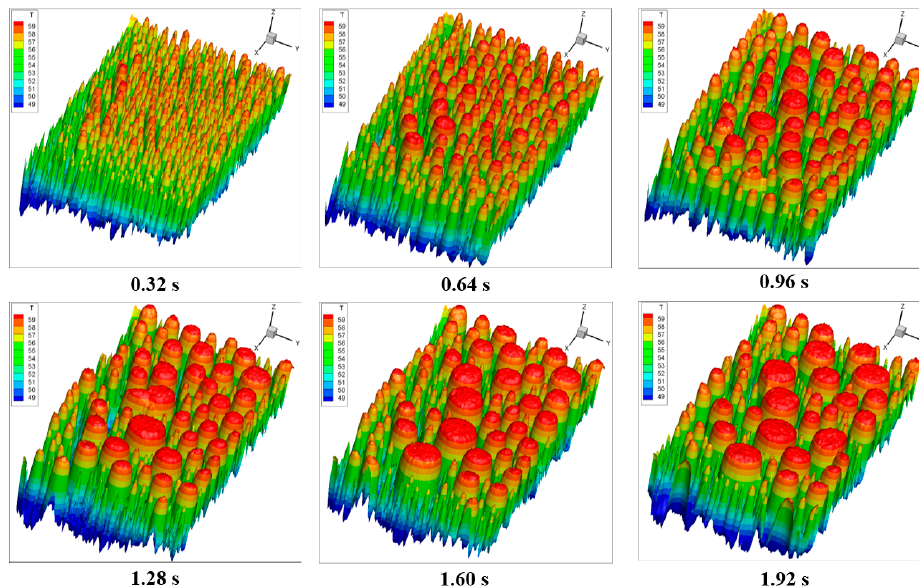
Figure 9. Front view of the temperature distribution of all the droplets on the condensing surface at different times.